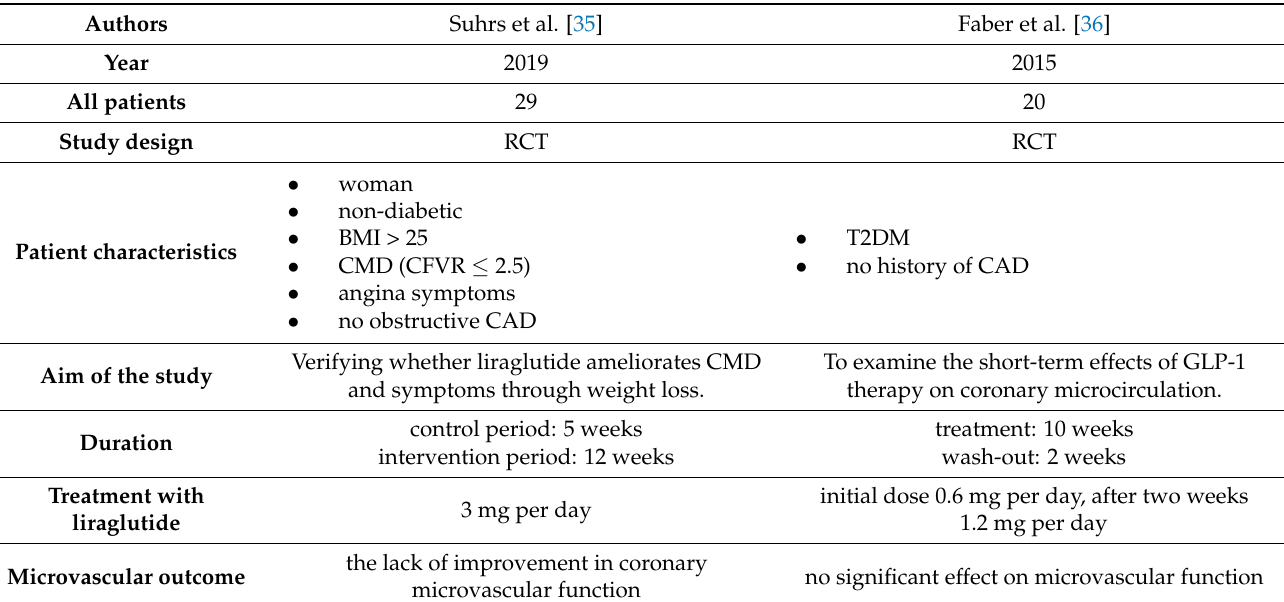
Table 5. Comparison of studies on the effect of liraglutide treatment on coronary microvascular function